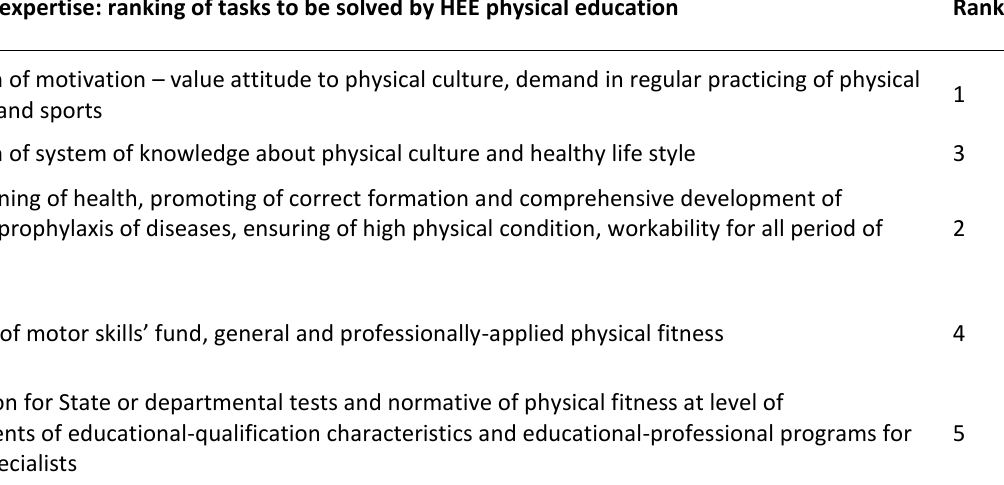
Table 1. Results of experts’ questioning about importance of tasks to be solved by HEE physical education (W = 0,82, n = 21)